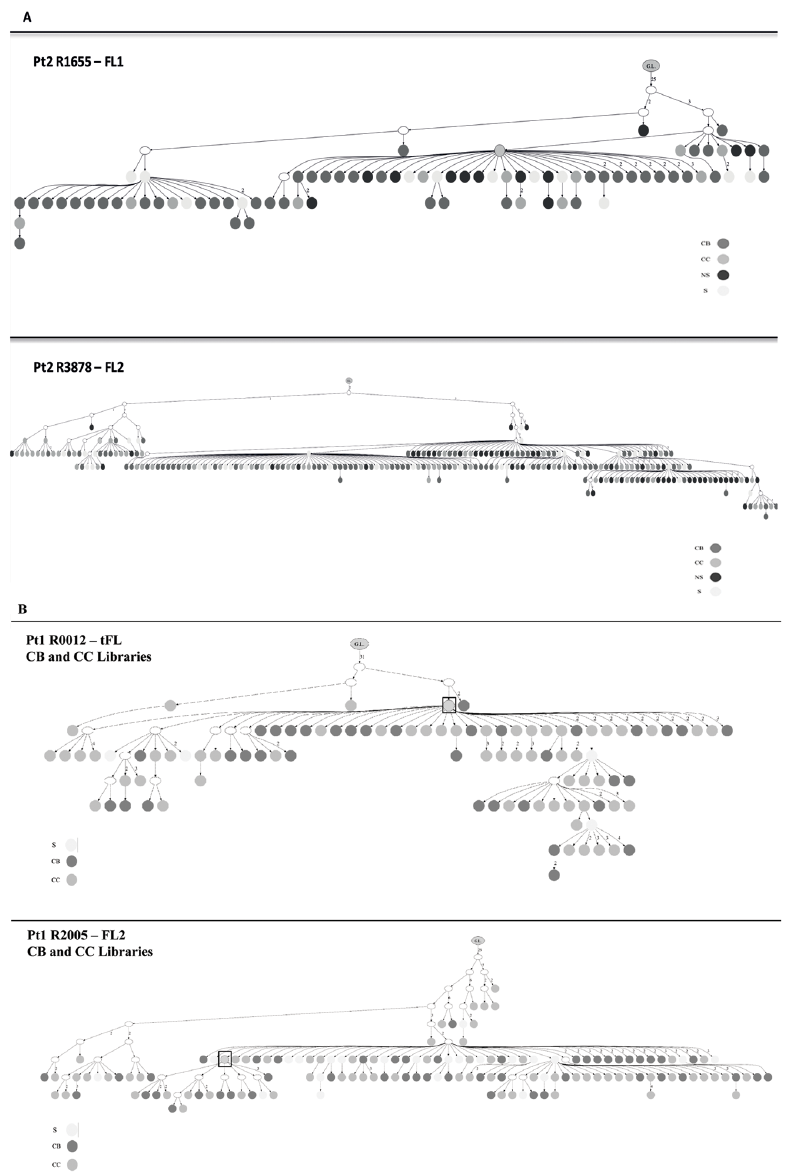
Fig 4. Merged Lineage Trees showing the dynamics of evolution of the sub-clones. (A) Merged lineage trees generated from the 2 biopsies R1655 FL1 and R3878 FL2 from pt2. G.L. means germline; the dark grey circles represent the CB clones, the medium grey circles the CC, the light grey circles the clones shared (S) among 2 or more populations and the black circles those from the not sorted (NS) whole biopsy. (B) Merged lineage trees obtained from the combination of the CB and CC libraries from the samples R0012 t-FL and R2005 FL2 from pt1. The dark grey circles represent the CB subclones, the medium grey circles the CC and the light grey circles the clones shared (S) by CB and CC. The white circles represent subclones not detected with the 454 sequencing. Squares highlight the MC. 4B and S5C Fig). We did not observe any difference between merged trees generated from the GC (CB/CC) populations from t-FL and FL samples from pt1 (Fig 4B), or when we compared the merged trees from pt1 (showing a direct evolution pattern and only post-treatment samples included in the analysis) with those from pt3 (displaying a CPC pattern and 2 pre-treatment